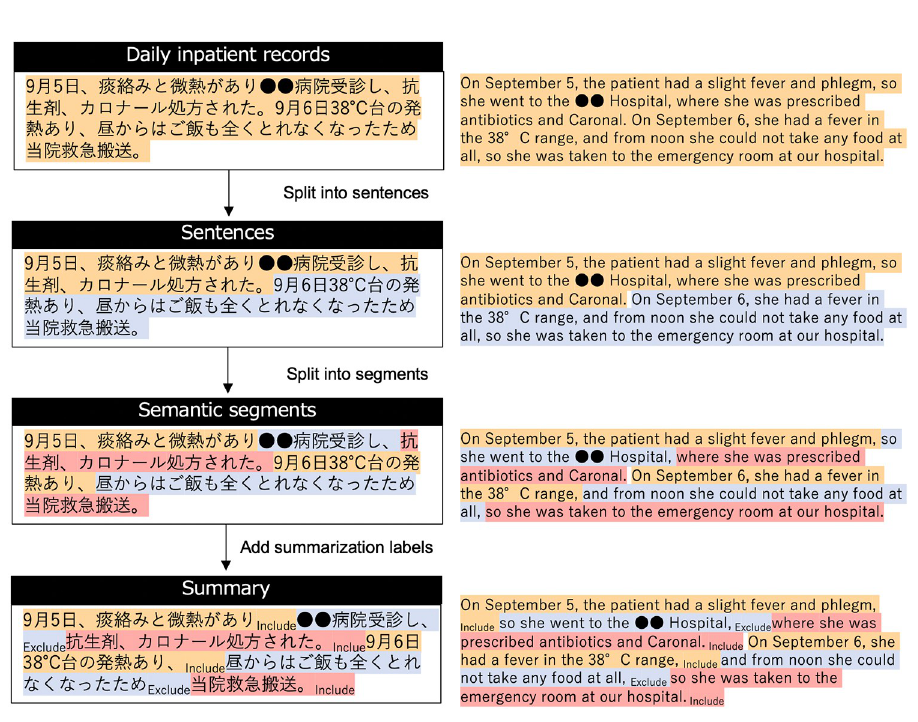
Fig 1. Outline of our pipeline. The top block is an example of the inpatient record, and the subsequent blocks indicate the chain of processes up to adding summarization